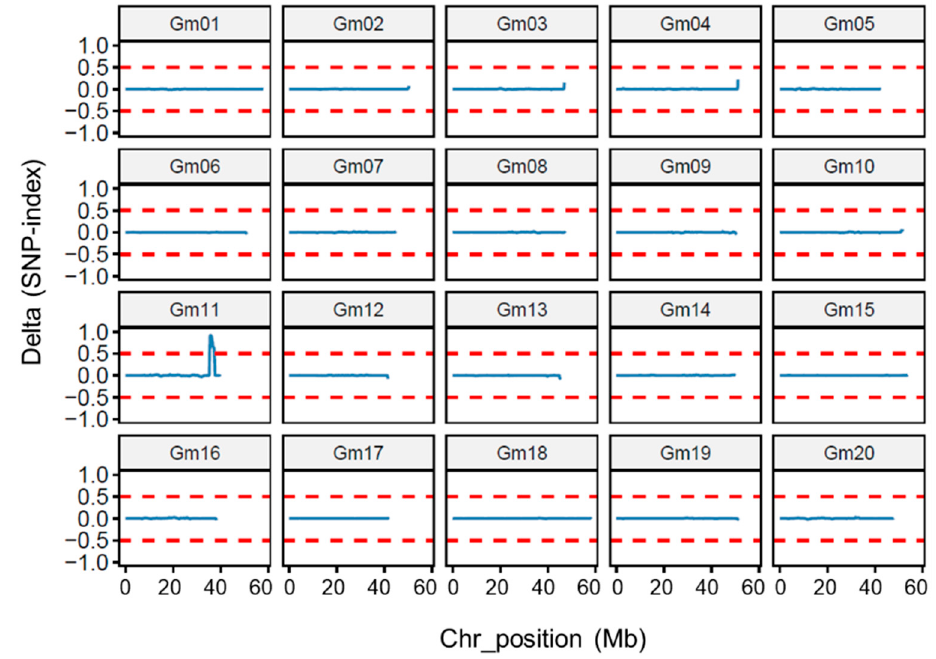
Figure 5. Distribution of delta SNP index values in 20 chromosomes of soybean. The x-axis indicates the physical position of chromosomes and the y-axis indicates delta SNP index values. Delta index = index (MT) − index (WT).